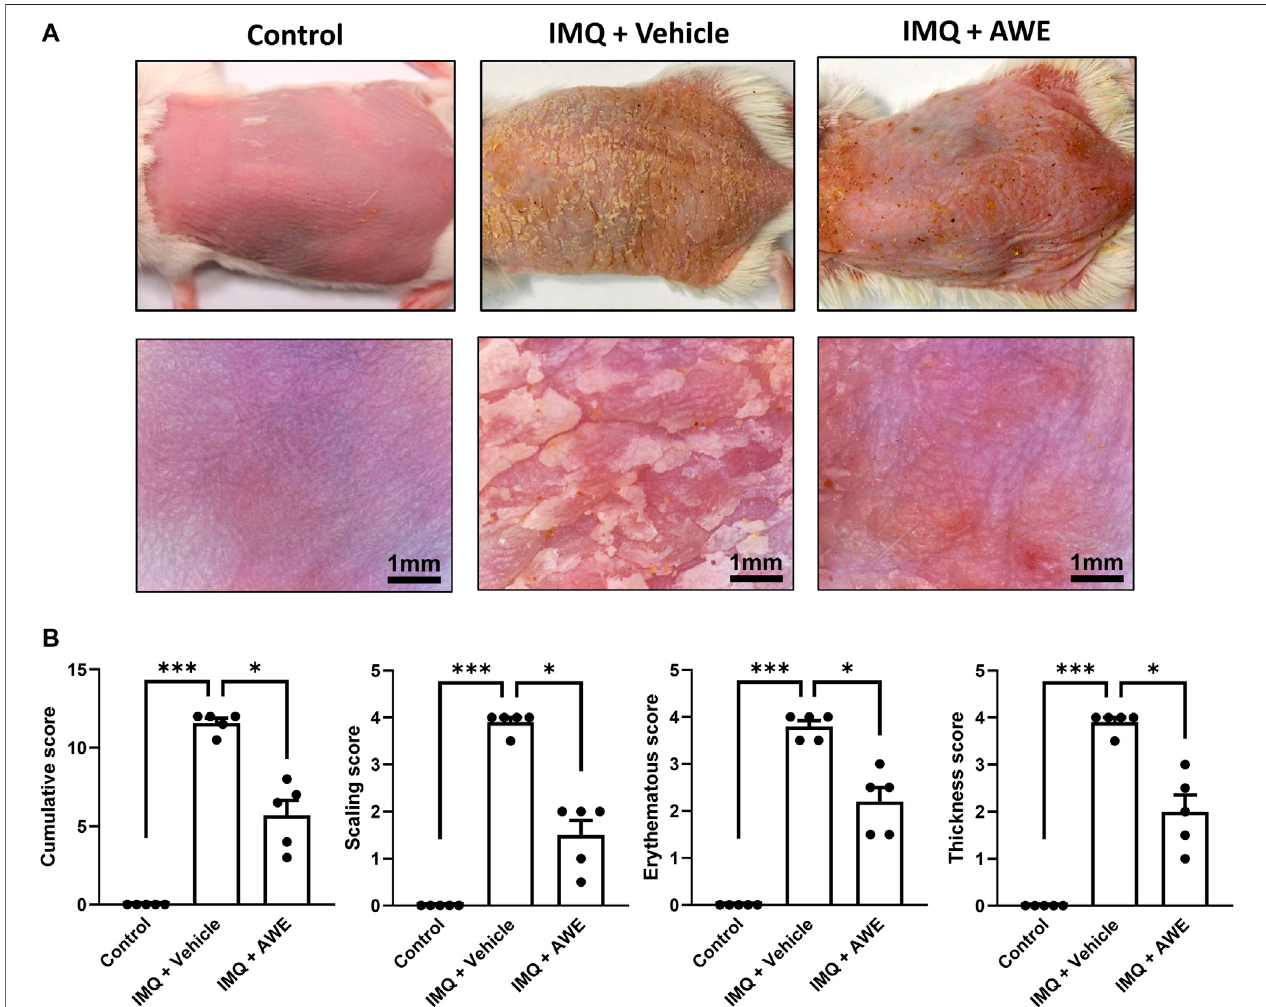
FIGURE 8 | A WE ameliorated the severity of IMQ-induced psoriasis-like skin in fl ammation. (A) The skin change of IMQ-induced psoriasis-like skin in fl ammation was observed using a digital camera and a hand-held digital microscope. The scale bar of the picture in a hand-held digital microscope was 1 mm. (B) PASI scores, includingerythema,thickness,scaling,andcumulativescoresinstudygroups,areshown.DataareexpressedasmeanS.E.M.( n (cid:2) 5).Statisticalanalysiswasconducted using the Kruskal – Wallis test, followed by multiple comparison test with the two-stage linear step-up procedure of Benjamini, Krieger, and Yekutieli if there were statistical differences in the results ofthe Kruskal – Wallis test. Adjusted q -valuesof multiple comparison tests using the two-stage linear step-up procedure ofBenjamini, Krieger, and Yekutieli were de fi ned as *** q < 0.001 and * q < 0.05 compared with the IMQ plus vehicle group.